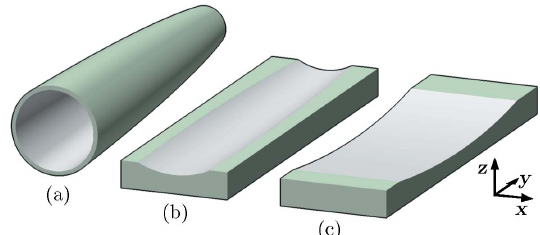
Figure 2 Two classifications of the same parent ellipse: Types I and II. Object and image positions are shown at the foci. The mirror portion, containing the point of intersection, is shown as a thicker segment of the parent ellipse, in green.